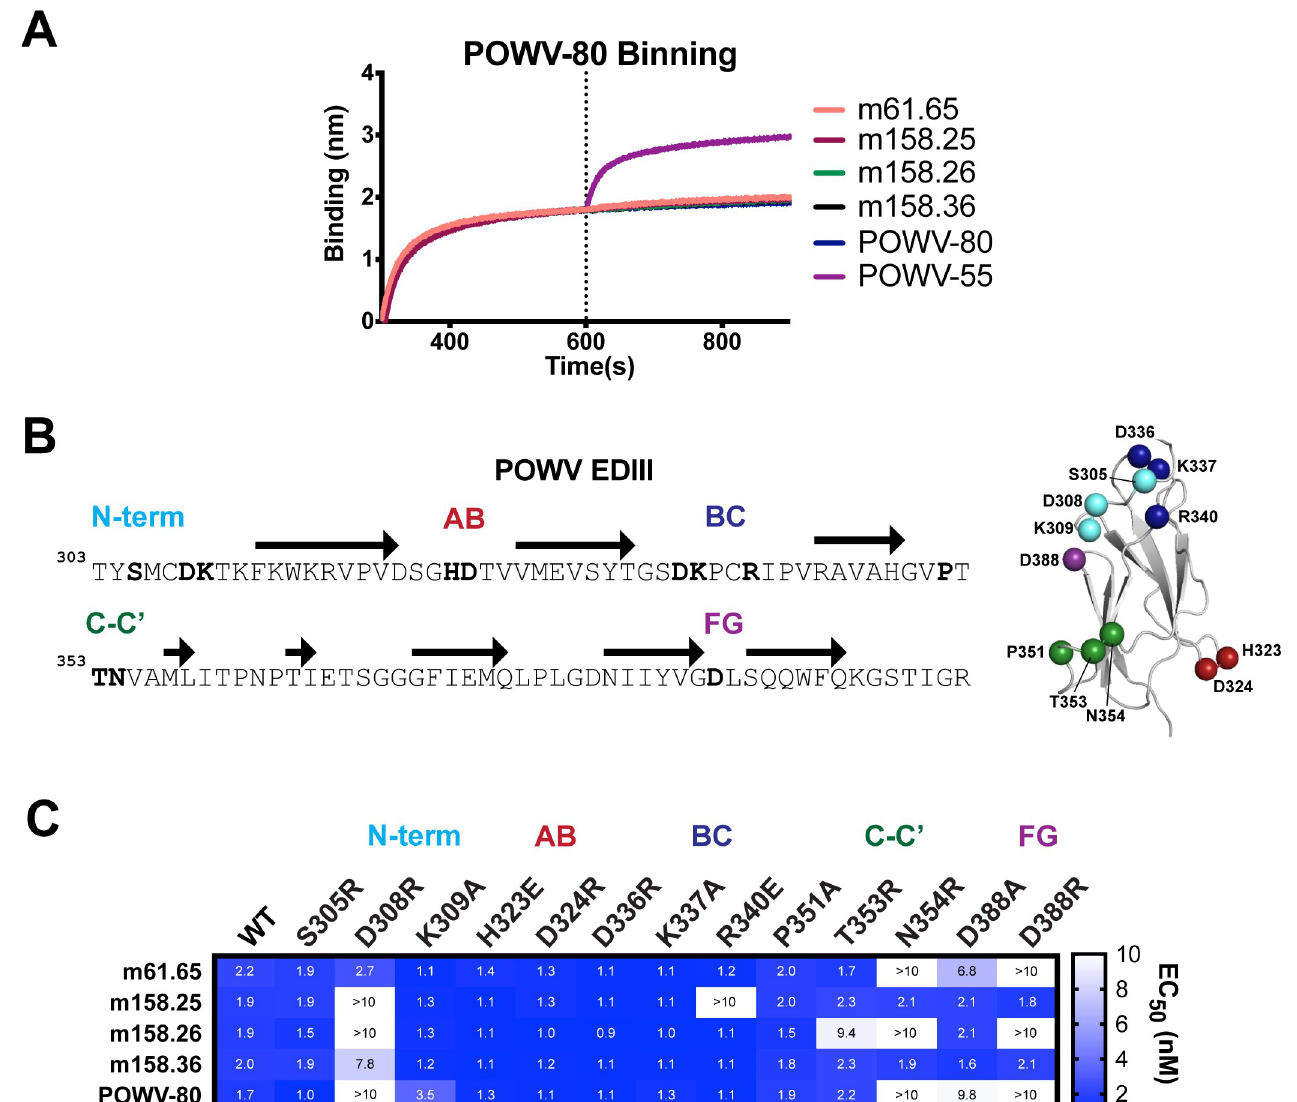
Fig 6. Epitope binning and mutagenesis mapping of neutralizing POWV EDIII mAbs. ( A ) Two-phase binding of neutralizing mAbs to POWV EDIII against mAb POWV-80 by BLI. MAb POWV-80 was bound to a sensor loaded with POWV EDIII followed by the sequential addition of the indicated second mAb. Representative data from two independent experiments is shown. ( B ) Sequence map of POWV EDIII for mutagenesis studies. Bolded residues in N- terminus, AB, BC, C-C’ and FG loops indicate positions where substitutions were introduced. Structure of POWV EDIII with mutations highlighted as C α spheres is shown. ( C ) Heatmap of EC 50 values of mAbs against MBP-POWV-EDIII mutants. EC 50 values were calculated using non-linear regression analysis of ELISA binding curves performed twice independently in triplicate wells (mean ±